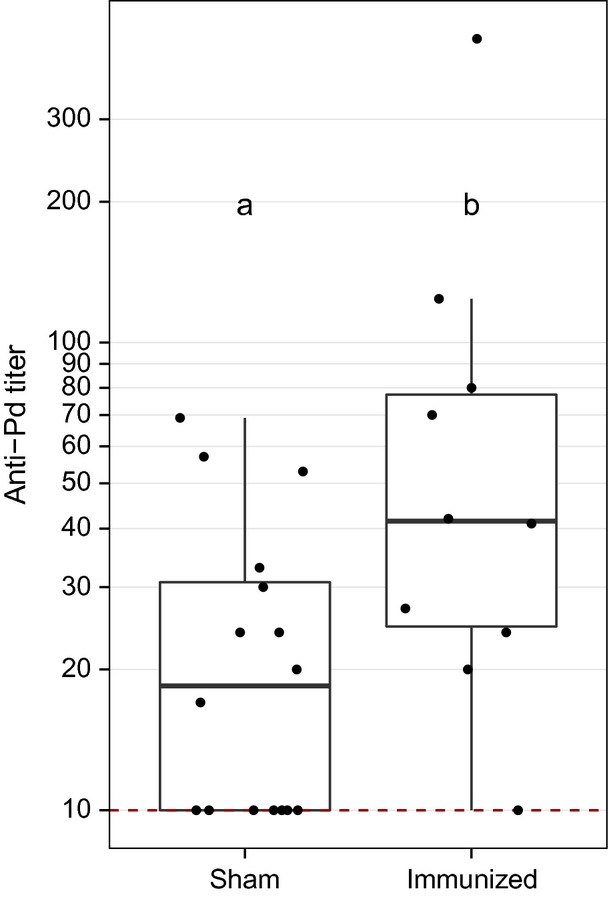
Comparison of anti-Pd antibody titers in 26 little brown myotis (Myotis lucifugus) collected from outside the WNS-affected region of North America and immunized with Pd emulsified with adjuvant or PBS (sham). Anti-Pd titers were greater in immunized bats, as denoted by different letters (P < 0.05). Data are presented as quartiles, median (black line), and whiskers that represent 1.5 times the interquartile range. Titers ≤ 10 are considered negative for Pd reactive antibodies.